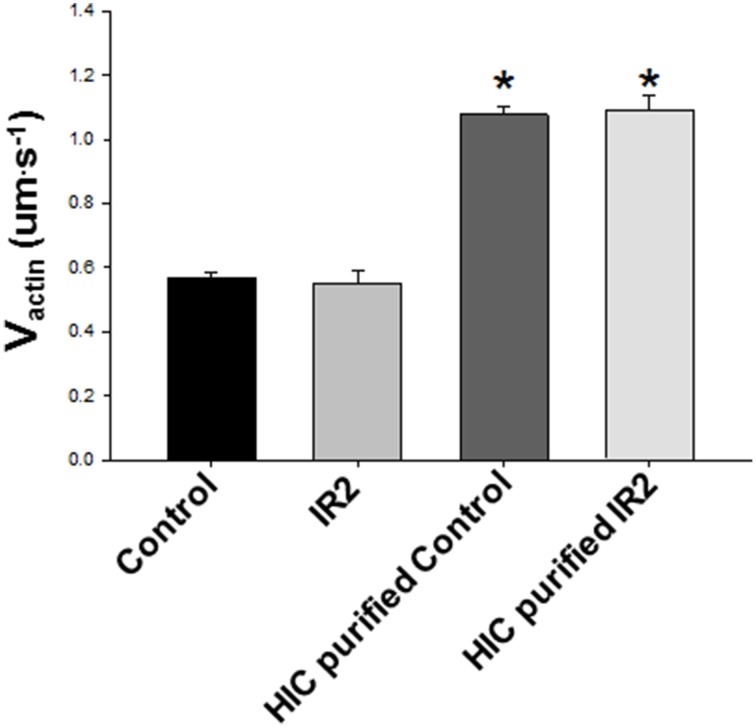
Purification with HIC column enhances Vactin. Further purification of the myosin using an HIC column nearly doubled Vactin from both Control tissue and tissue exposed to ischemia (IR2) and 2 h of reperfusion (p < 0.001). However, there was no difference between conditions with either the isolated myosin or the HIC purified myosin. The data represent the average actin filament velocities from 106 to 30 s videos from Control and 19 from IR2, as well as five videos each for HIC purified Control and IR2 purified samples. * Indicates significance at p < 0.05.